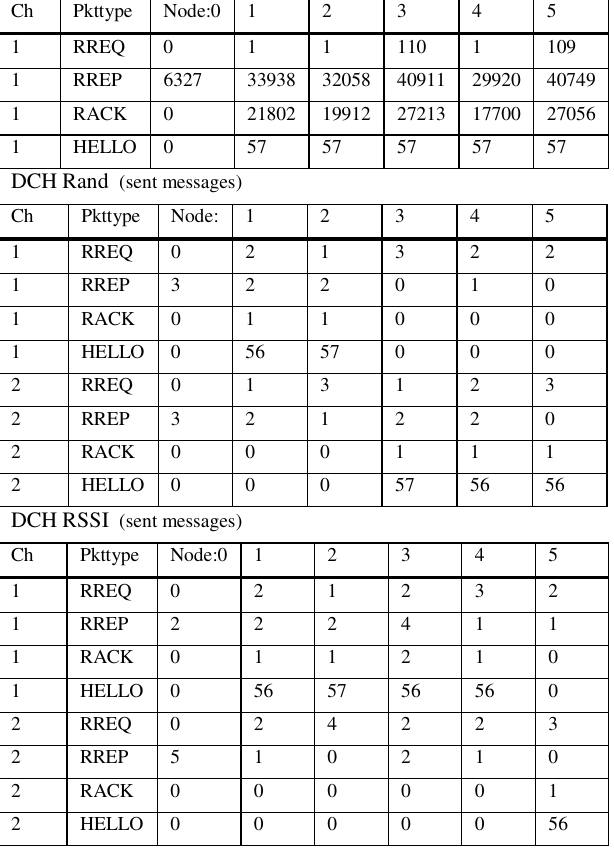
Table 3: Count of AODV control messages received by a node all other nodes for SCH, DCH Rand and DCH RSSI